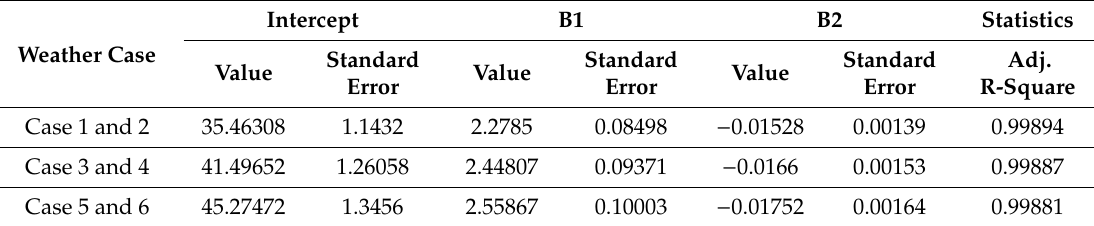
Table 5. Regression analysis results according to polynomial fitting: Simulation under ambient temperature (25 ◦ C)